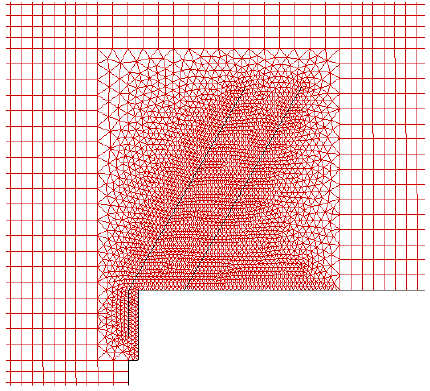
Figure 3. Local calculation grid.